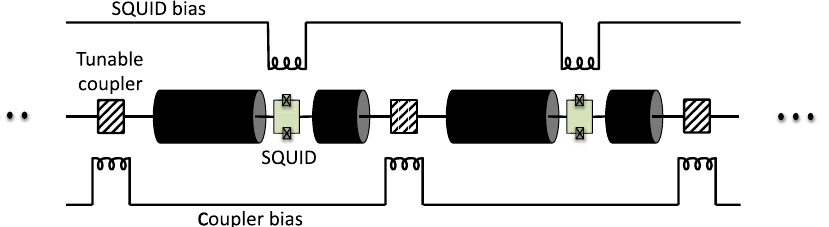
FIG. 1. System schematic. For simplicity, ground connections are not shown. CPW resonators (black shaded cylinders) form a one- dimensional array. Each resonator has a SQUID (green shaded boxes) connected to its center conductor and is coupled to its nearest neighbors with flux-tunable couplers (line-hatched boxes). The SQUIDs induce a flux-tunable nonlinearity into the resonator modes. Two bias lines are used to globally tune the SQUIDs and couplers separately. The first resonator (not shown) has a separate bias line for its